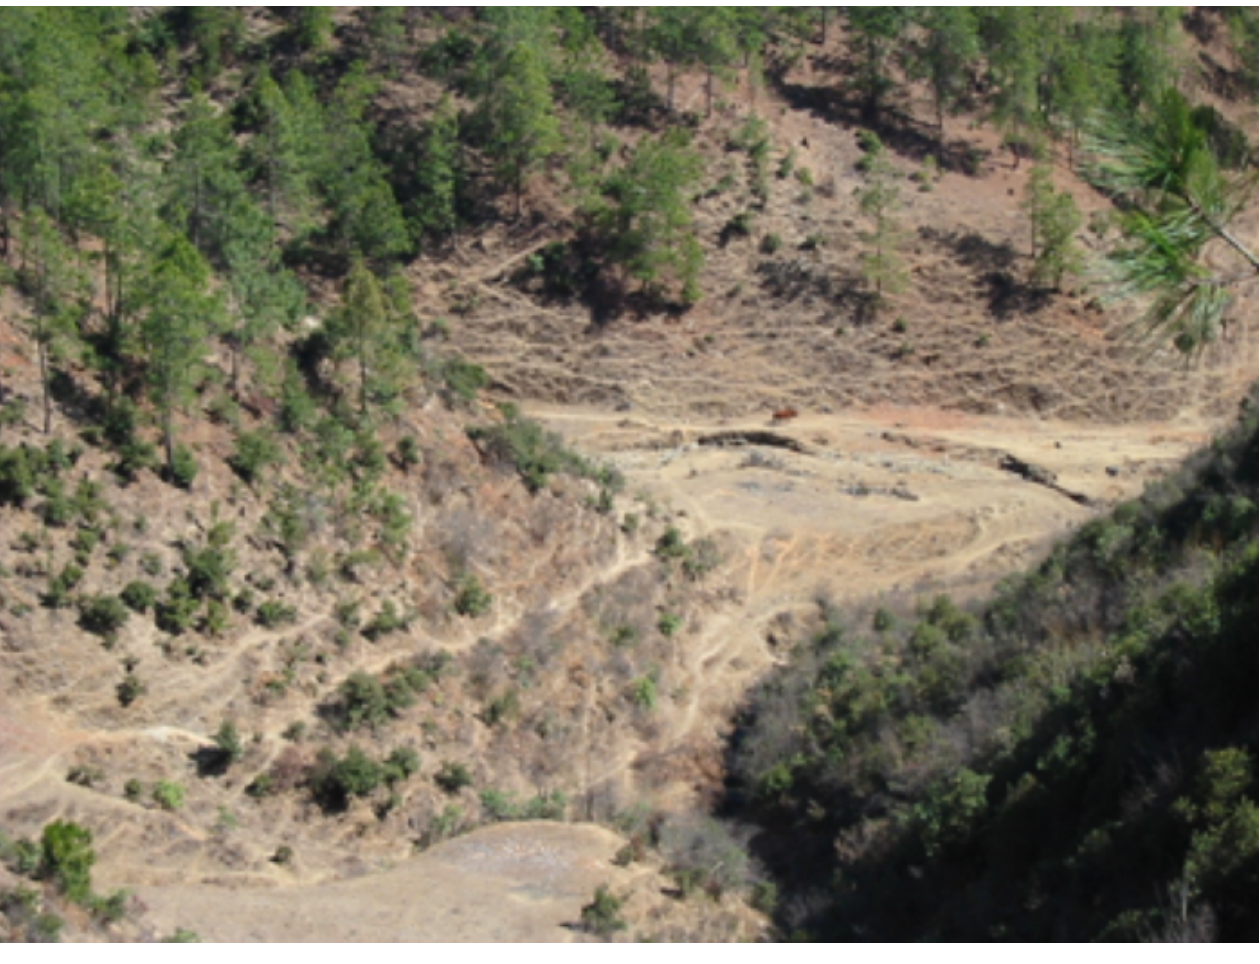
Fig. 4. View of part of the Laizigou watershed in the dry season, showing heavily eroded hillsides, braided animal trails, and a sparse overstory of Pinus yunnanensis on south-facing slopes and scrub vegetation on north-facing slopes. Photo: Shermi